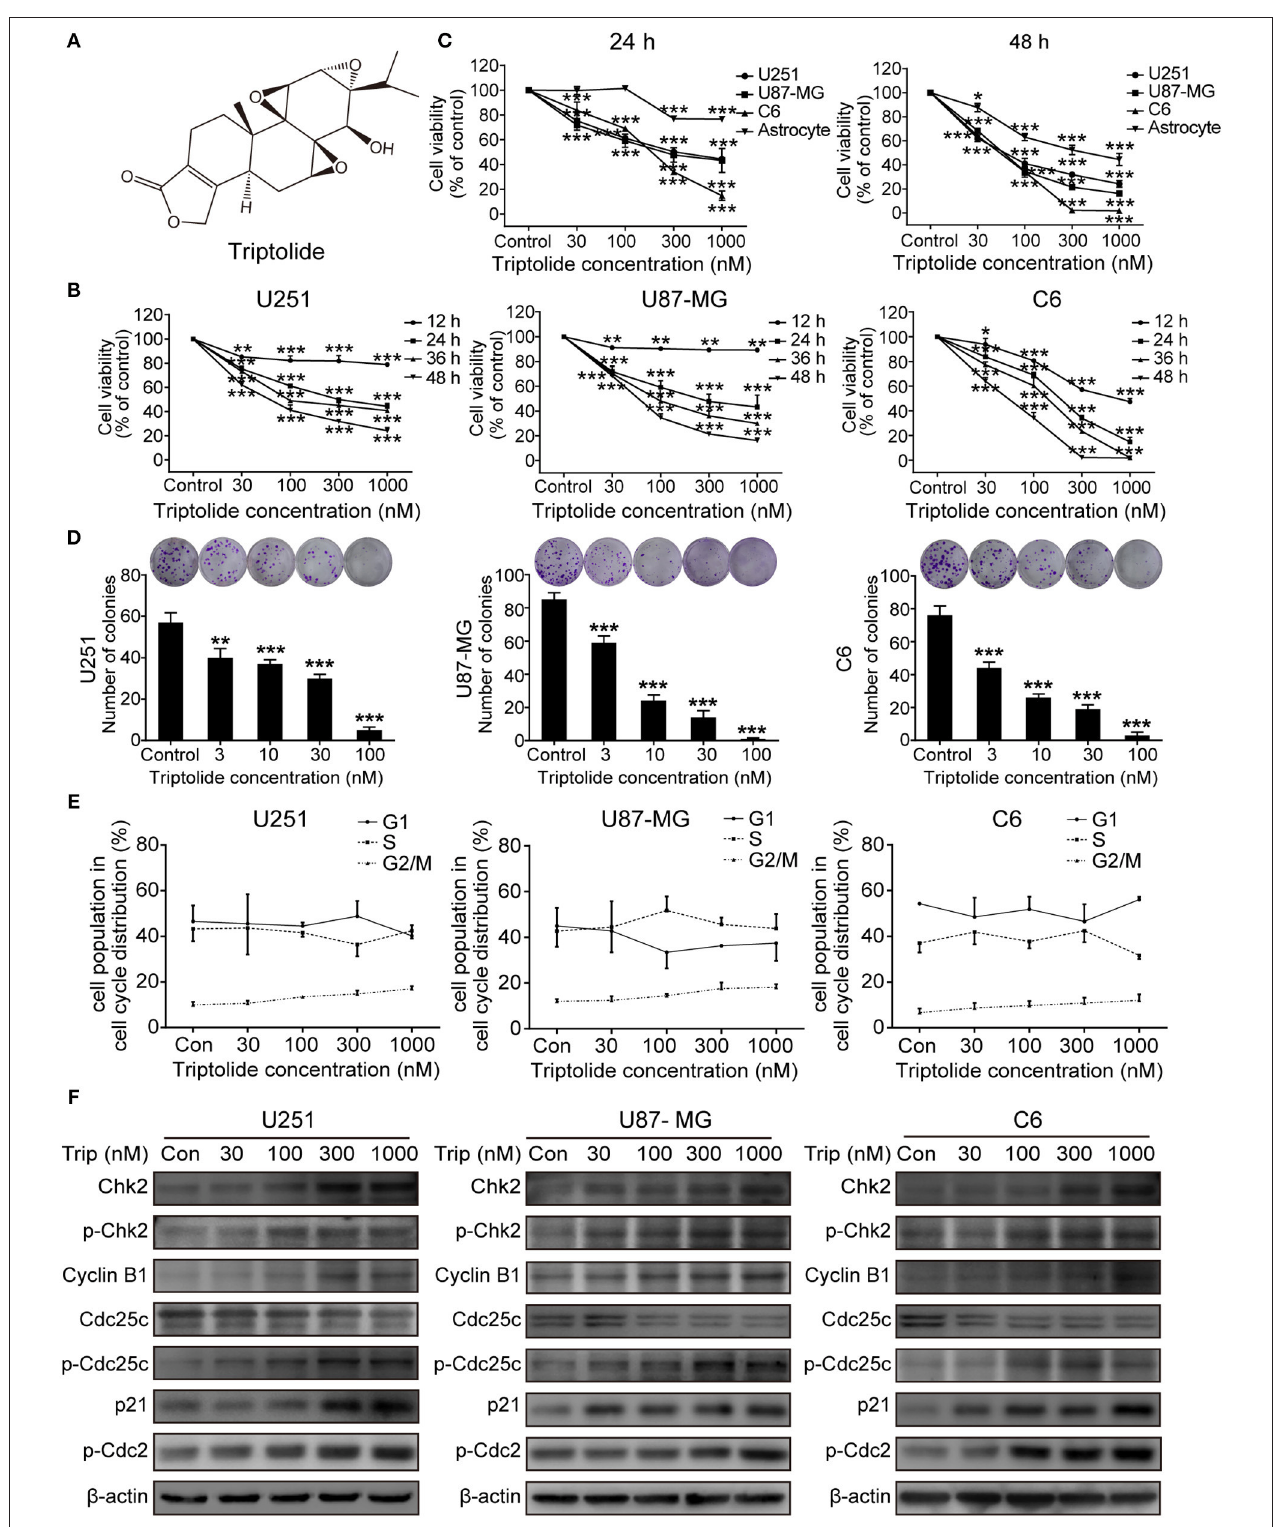
FIGURE 1 | Triptolide (Trip) inhibited the proliferation of glioma cells and arrested cells in the G2/M phase. (A) Chemical structure of triptolide. (B) U251, U87-MG and C6 cells were treated with the indicated concentrations of triptolide or vehicle (DMSO) for 12–48h, and the cell viability was quantified by a CCK8 assay.